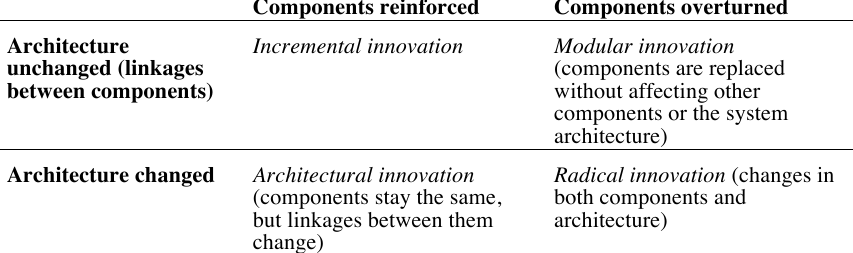
(components are replaced without affecting other components or the system architecture) Radical innovation (changes in both components and